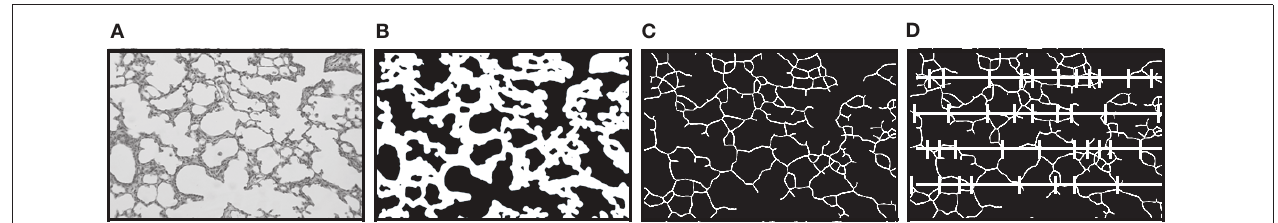
FIGURE 1 | Schema for the process of quantitating mean linear intercept. (A) Hematoxylin and eosin stained lung tissue section as an example of the digitalimagesobtainedforanalysis. (B) Abinaryimageofthephotomicrograph converted by a macro program. (C) The binary alveolar structure is next